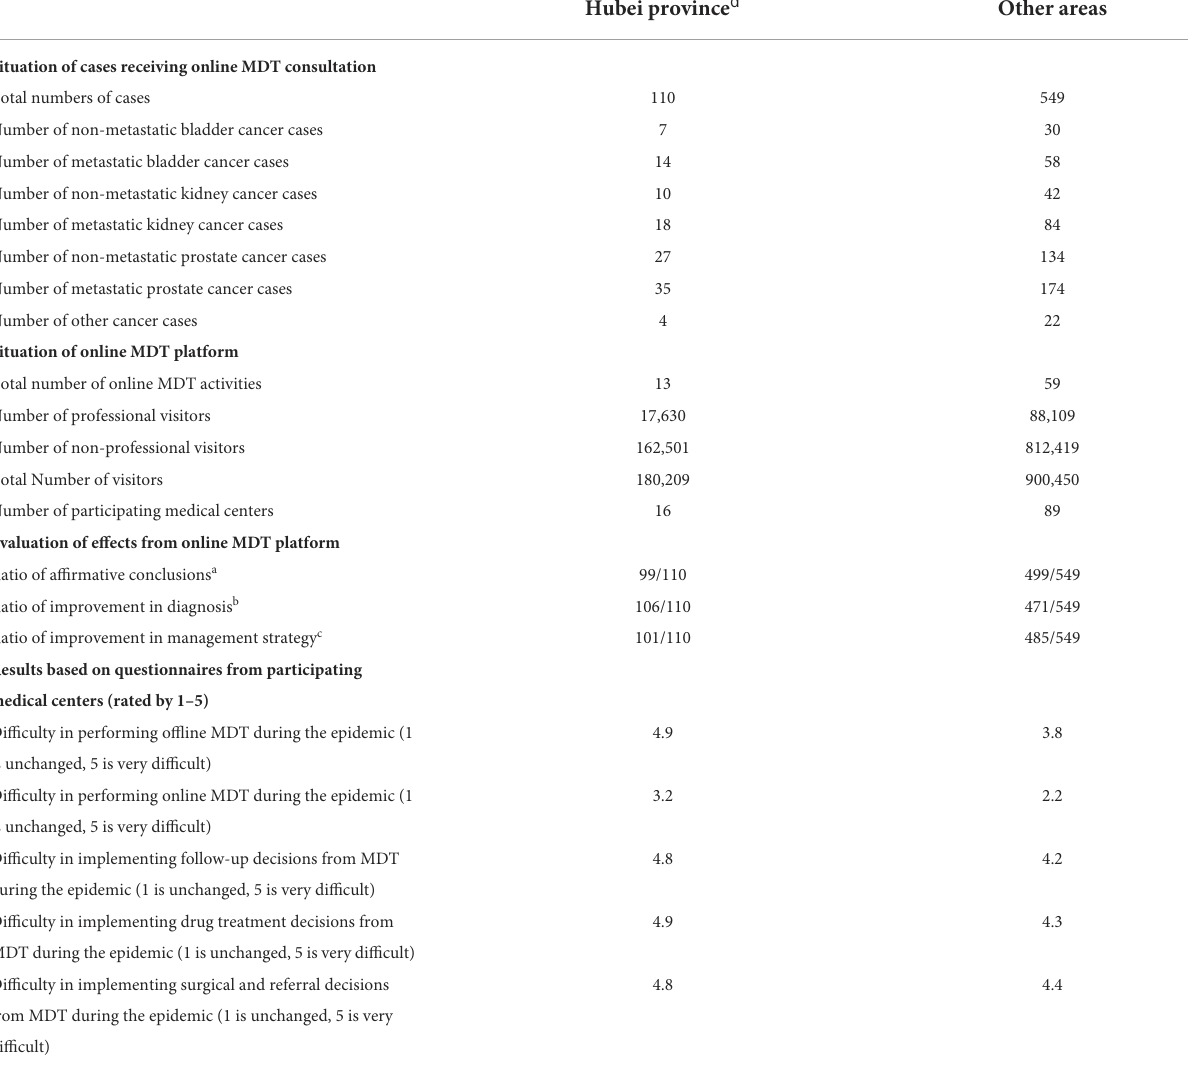
TABLE 2 An overview of the operation status of the Internet-based multidisciplinary management in patients with genitourinary cancer in China by different areas during the COVID-19 epidemic. Hubei province d Other